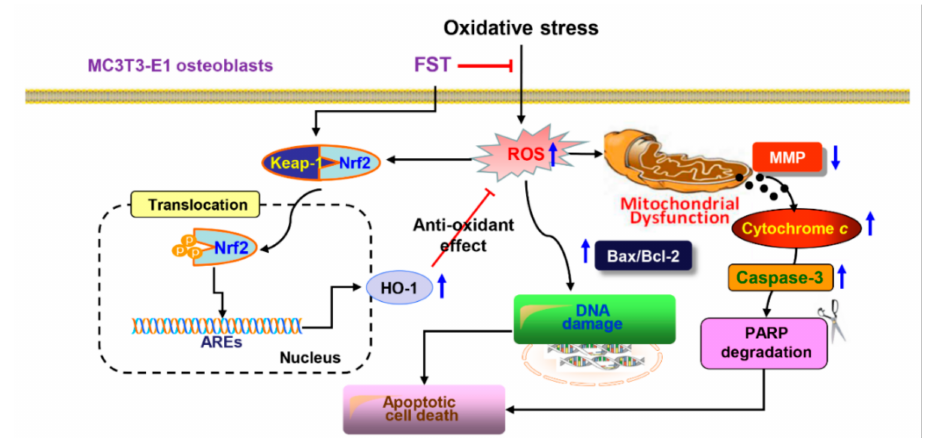
Figure 9. Scheme summarizing the protective effect of FST against oxidative stress-induced MC3T3- E1 osteoblast apoptosis by inhibiting ROS-dependent mitochondrial dysfunction and activating Nrf2/HO-1 antioxidant response